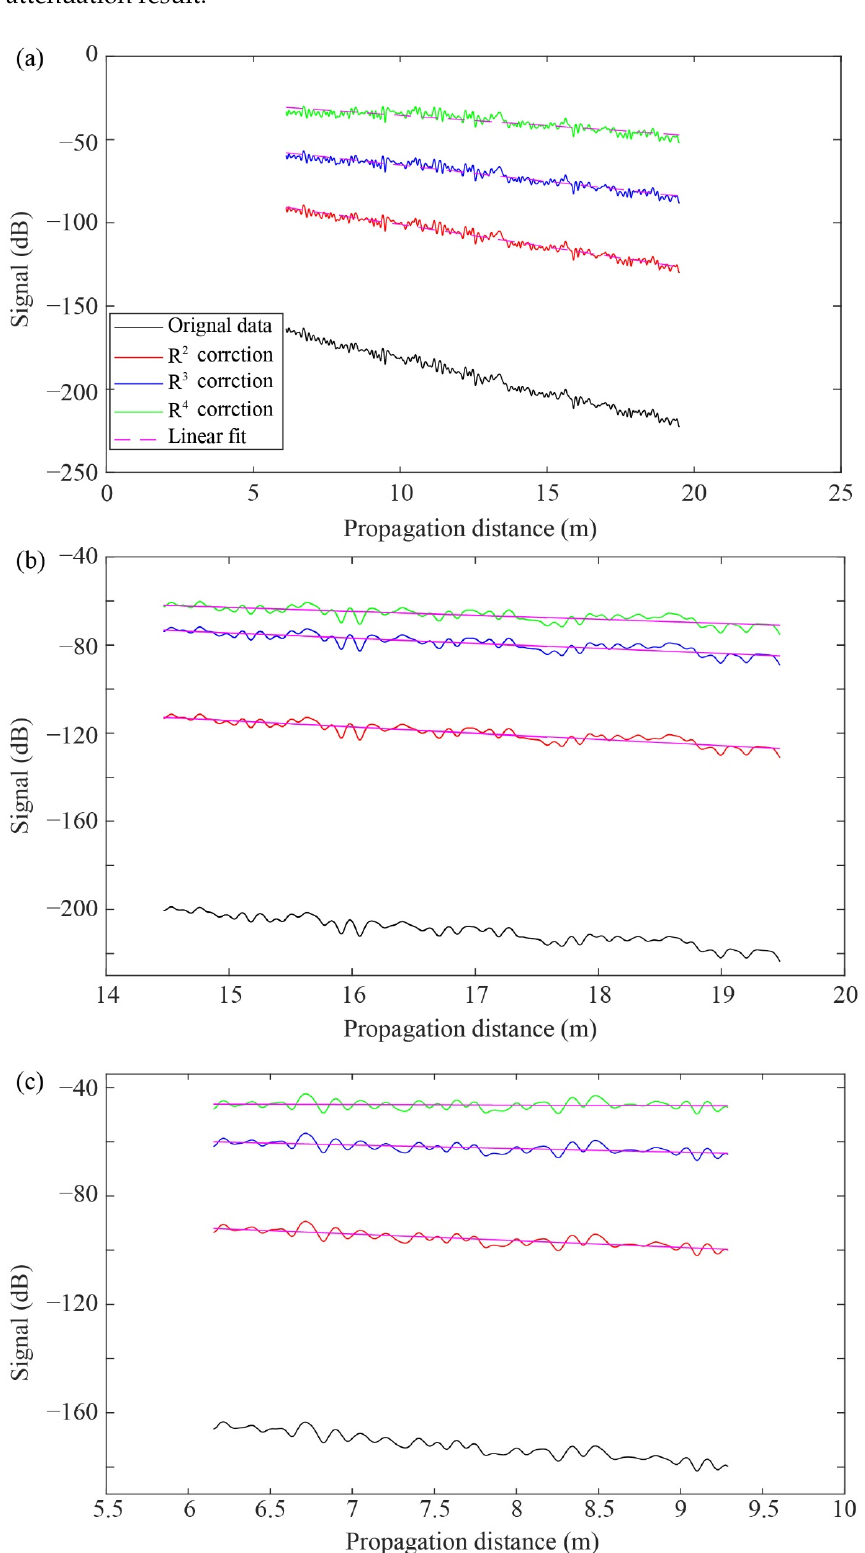
Figure 5. Estimated attenuation results. ( a ), ( b ) and ( c ) present the attenuation estimated result of the Model one, two and three, respectively. ε = 3.5 is used for time-to-propagation distance